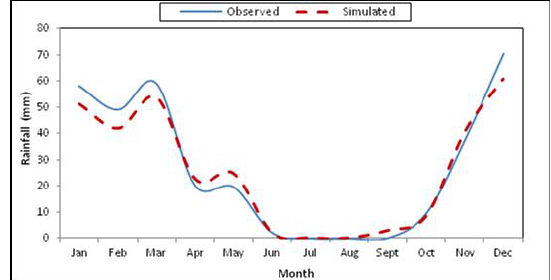
Figure 4. Average monthly rainfall of the observed & the simulated during calibration and validation periods (1961-2001).